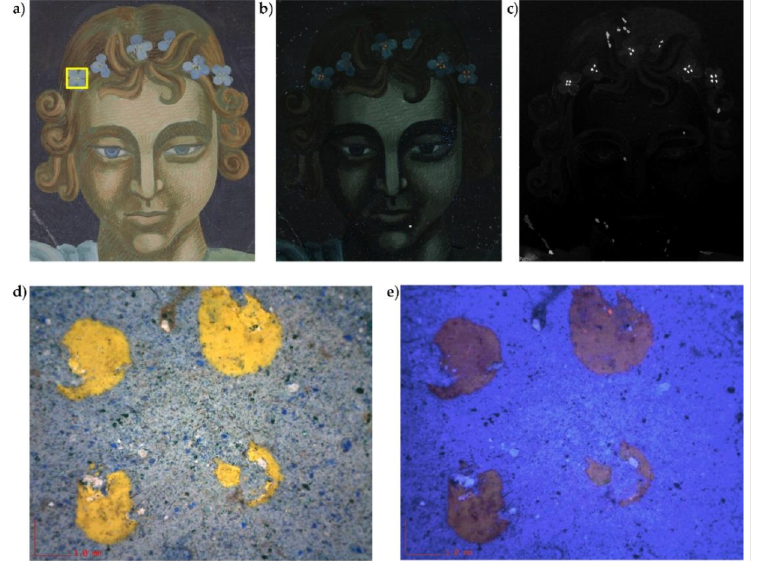
Figure 9. ( a ) Vis, ( b ) UVL and ( c ) VIL images (image size ca. 25 cm × 30 cm) of the angel depicting in the Holy family ; ( d ) Vis and ( e ) UVL images collected by digital microscope (magnification 50 × ) on the area indicated with a yellow square in ( a